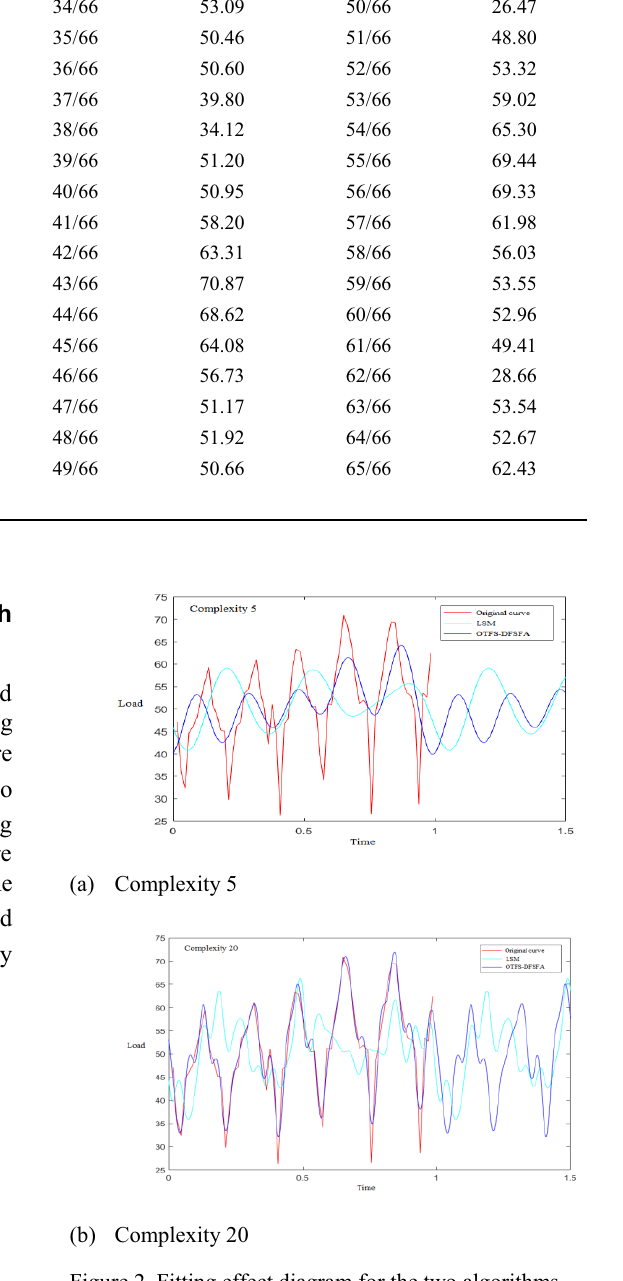
Figure 1. Comparison of the two algorithms for MSE descent speed.